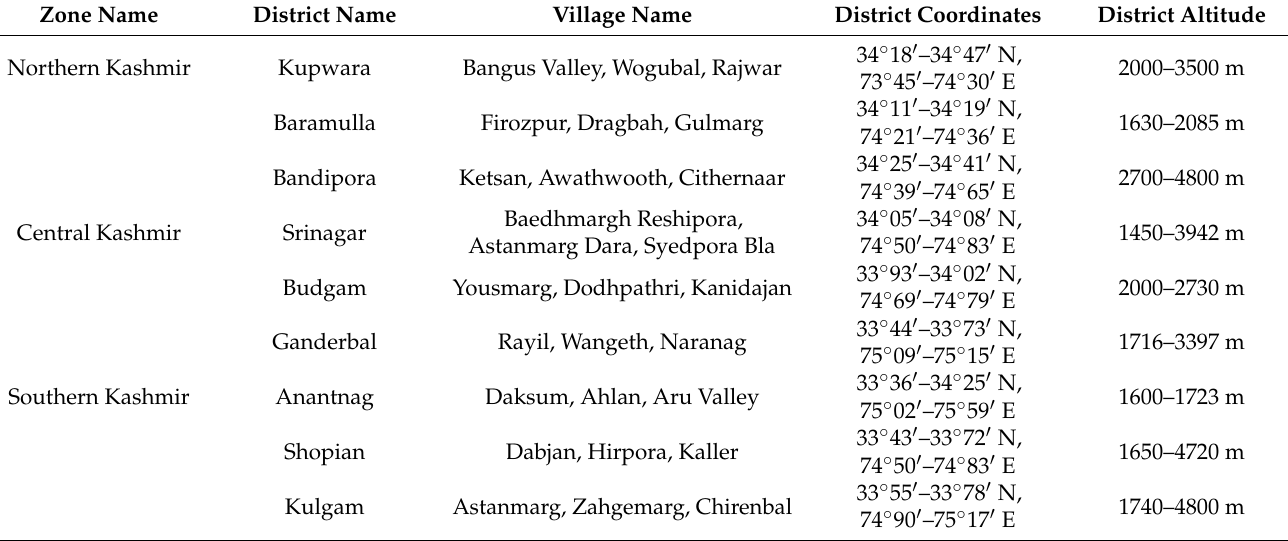
Table 9. Spatial distribution of studied